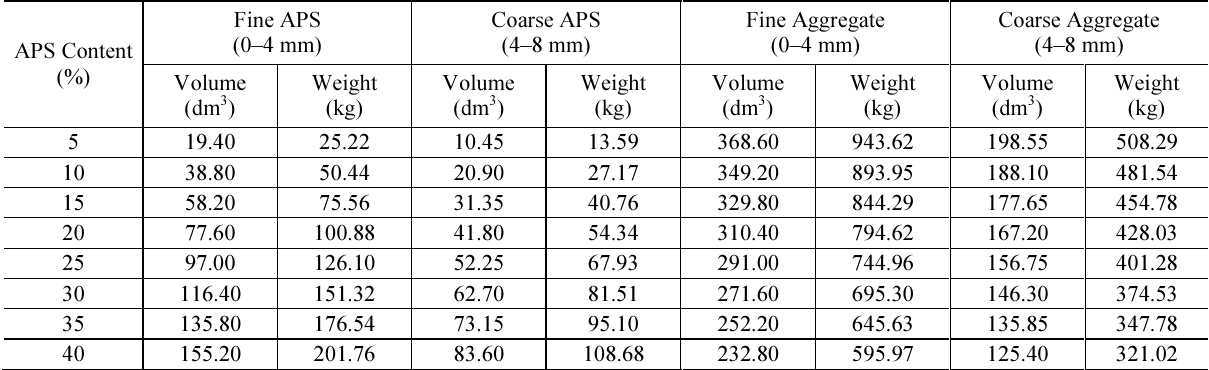
Table 1. APS and limestone aggregate quantities for 1 m